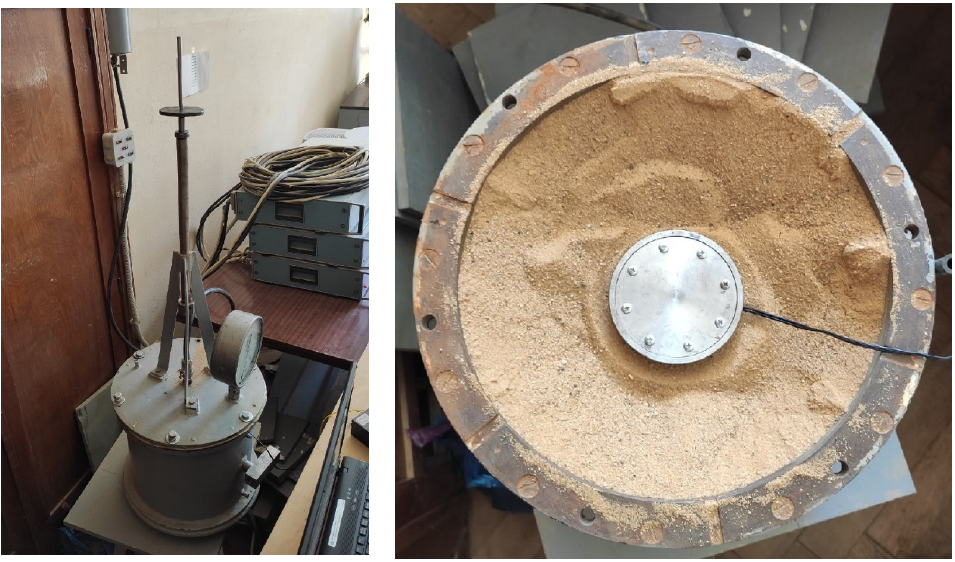
Figure 14. Calibration unit.